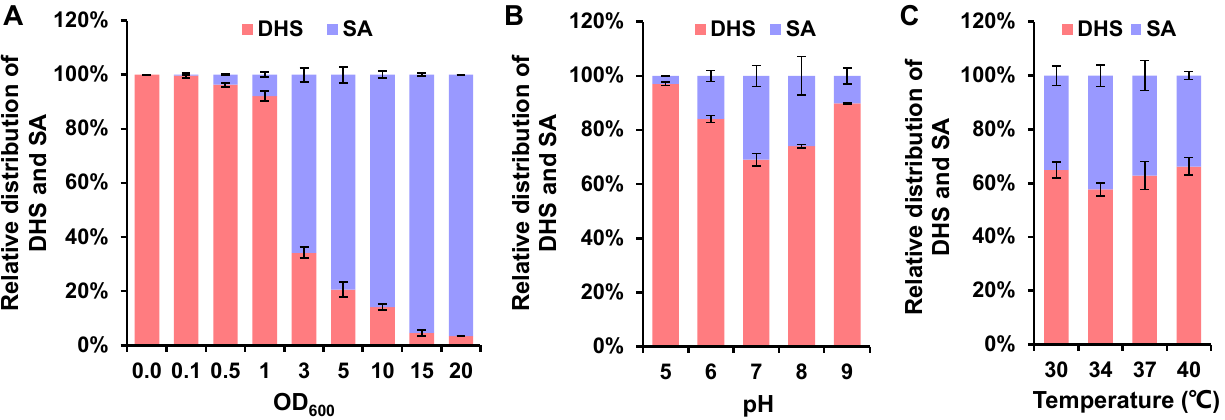
Figure 3. Effects of OD 600 ( A ), pH ( B ), and temperature ( C ) on bioconversion of DHS to SA by the PET whole-cell biocatalyst. The biocatalyst load for the whole-cell biocatalytic process was tested between 0.1 and 20 OD 600 at 37 °C, pH 7.0. The pH optimum of the whole-cell biocatalytic process was determined between pH 5.0 and 9.0 using 100 mM sodium phosphate buffer at 37 °C, with 2 OD 600 of PET whole-cell biocatalyst. The temperature optimum of the whole-cell biocatalytic process was determined at various temperatures (30–40 °C) at pH 7.0, with 2 OD 600 of PET whole-cell biocatalyst. All reactions were performed in 10 mL of 100 mM sodium phosphate buffer using 100 mM DHS and 150 mM glucose as substrates. Data are presented as the mean ± standard deviation of three independent experiments.